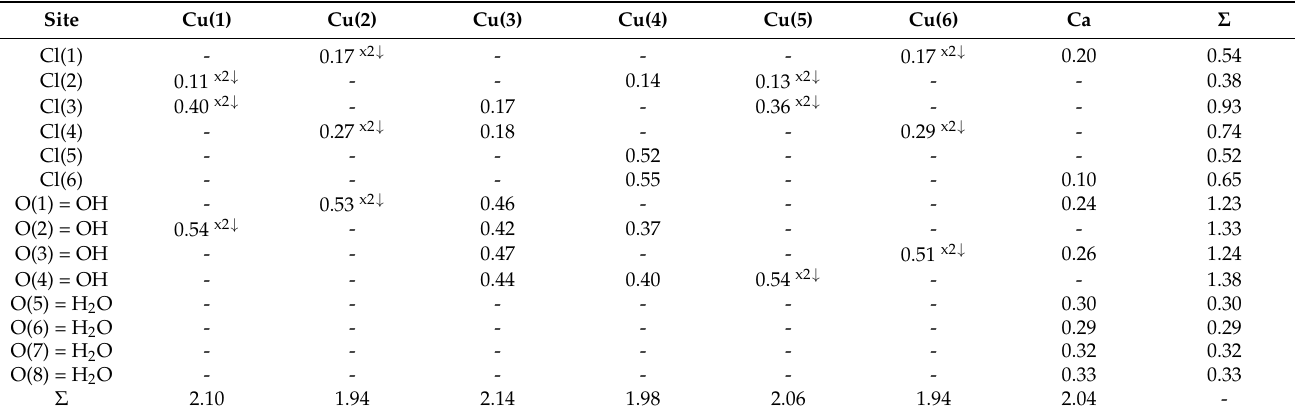
Table 7. Bond-valence calculations for dioskouriite-2 M